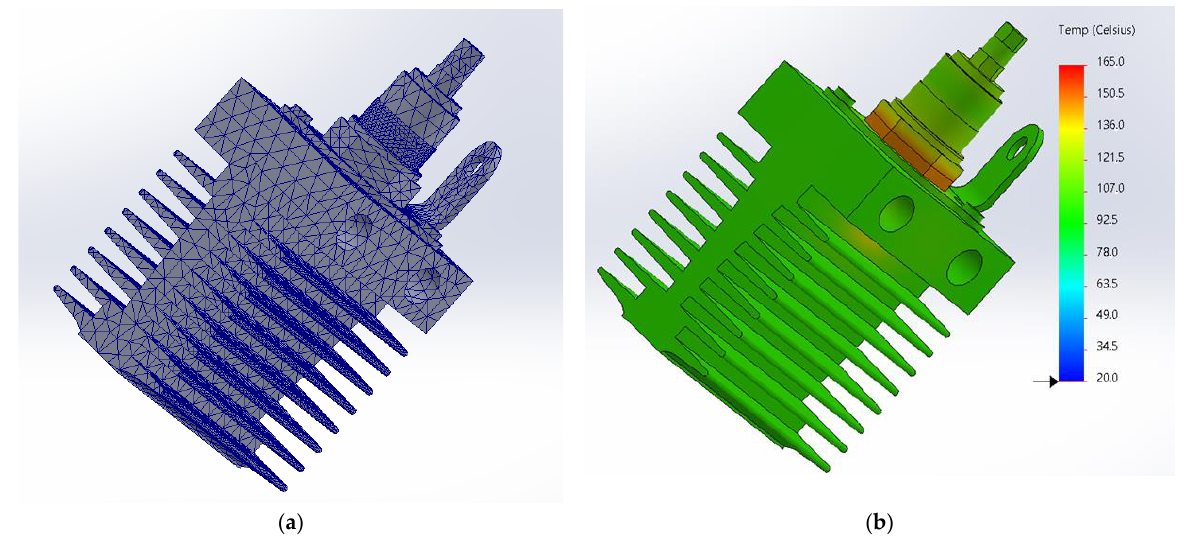
Figure 10. ( a ) The view of the diode model for the smallest mesh element value of 2.5 mm. (b) The simulation result for the smallest mesh element value of 2.5 mm ( t s = 65 s; T j = 162.7 °C; P j = 117.99 W; the temperature ranges from 20 °C to 165 °C).